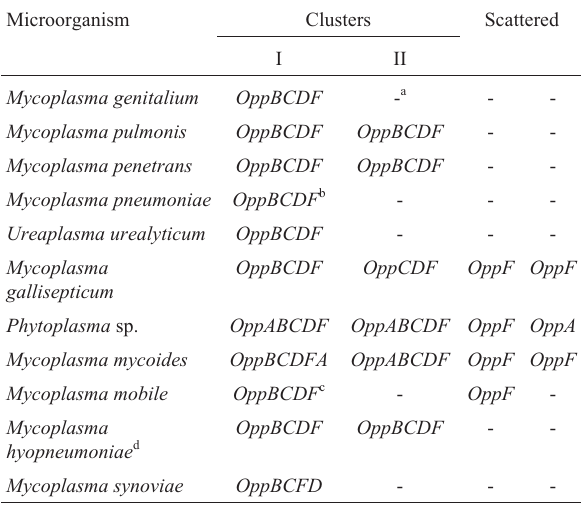
Table 1 - Genomic organization of Opp uptake system in mycoplasmas. The five components are disposed in clusters or as isolated ORFs in the